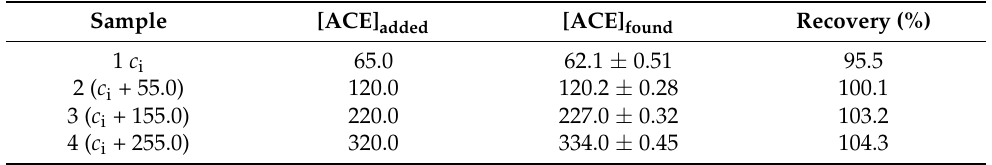
Table 2. Recovery data for acetamiprid in fortified tomatoes